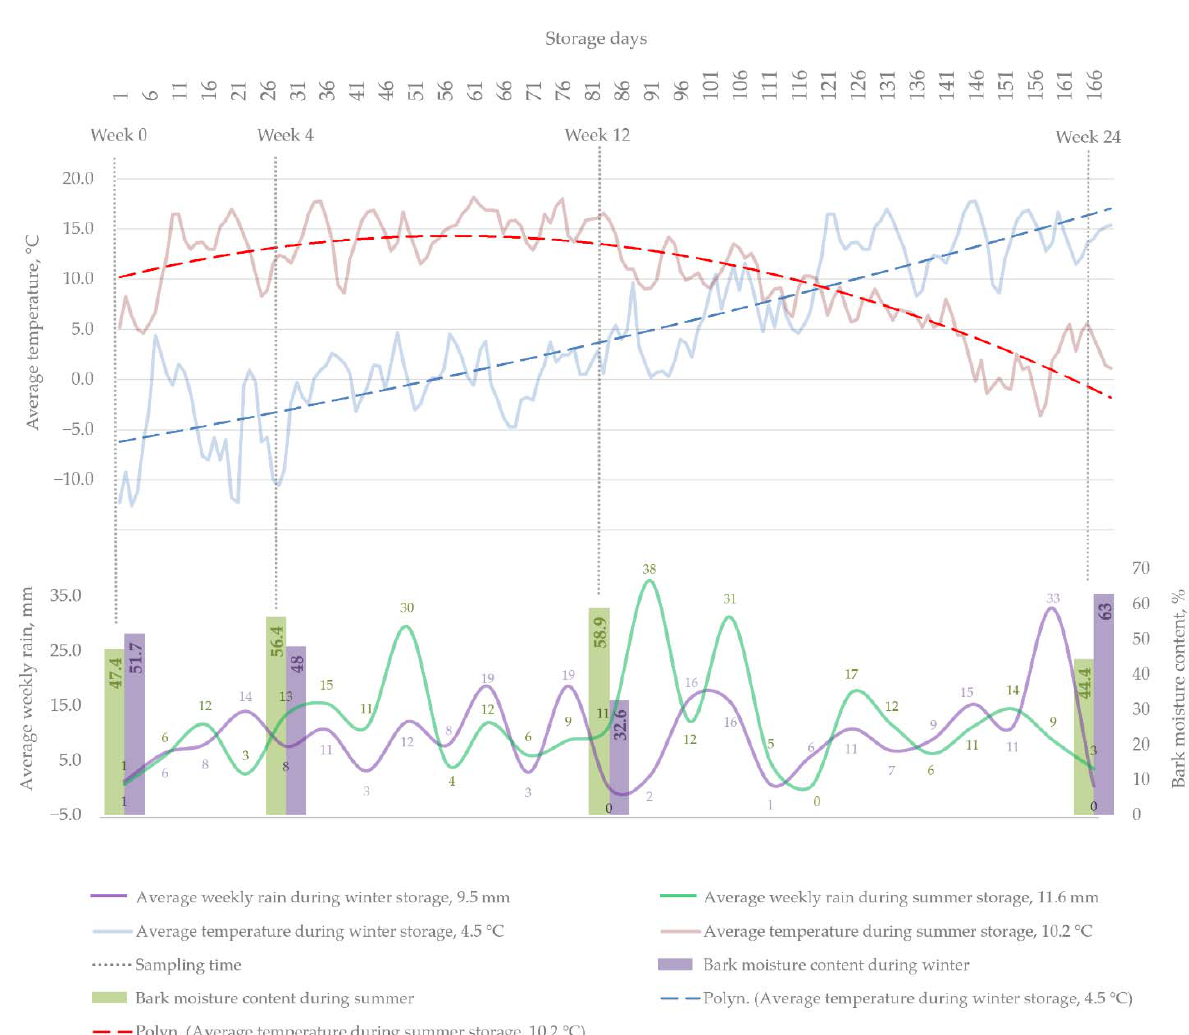
Figure 2. Average ambient temperatures and weekly amounts of rain during winter and summer storage, and the initial moisture content of bark samples at each sampling point. The sampling points (weeks 0, 4, 12 and 24) are indicated by vertical dotted lines.